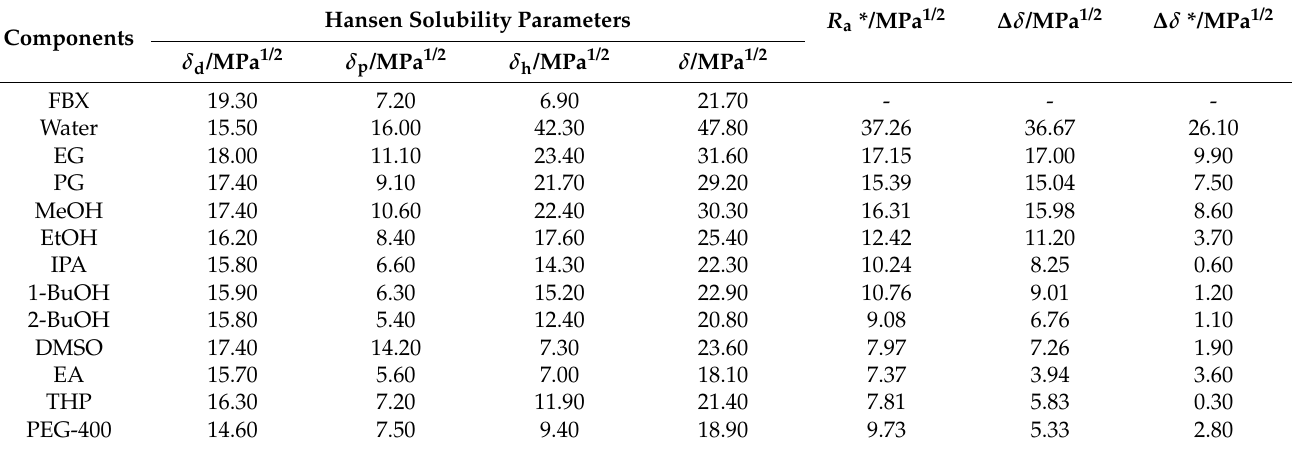
Table 2. Different solubility parameters of FBX and several MS at 298.2